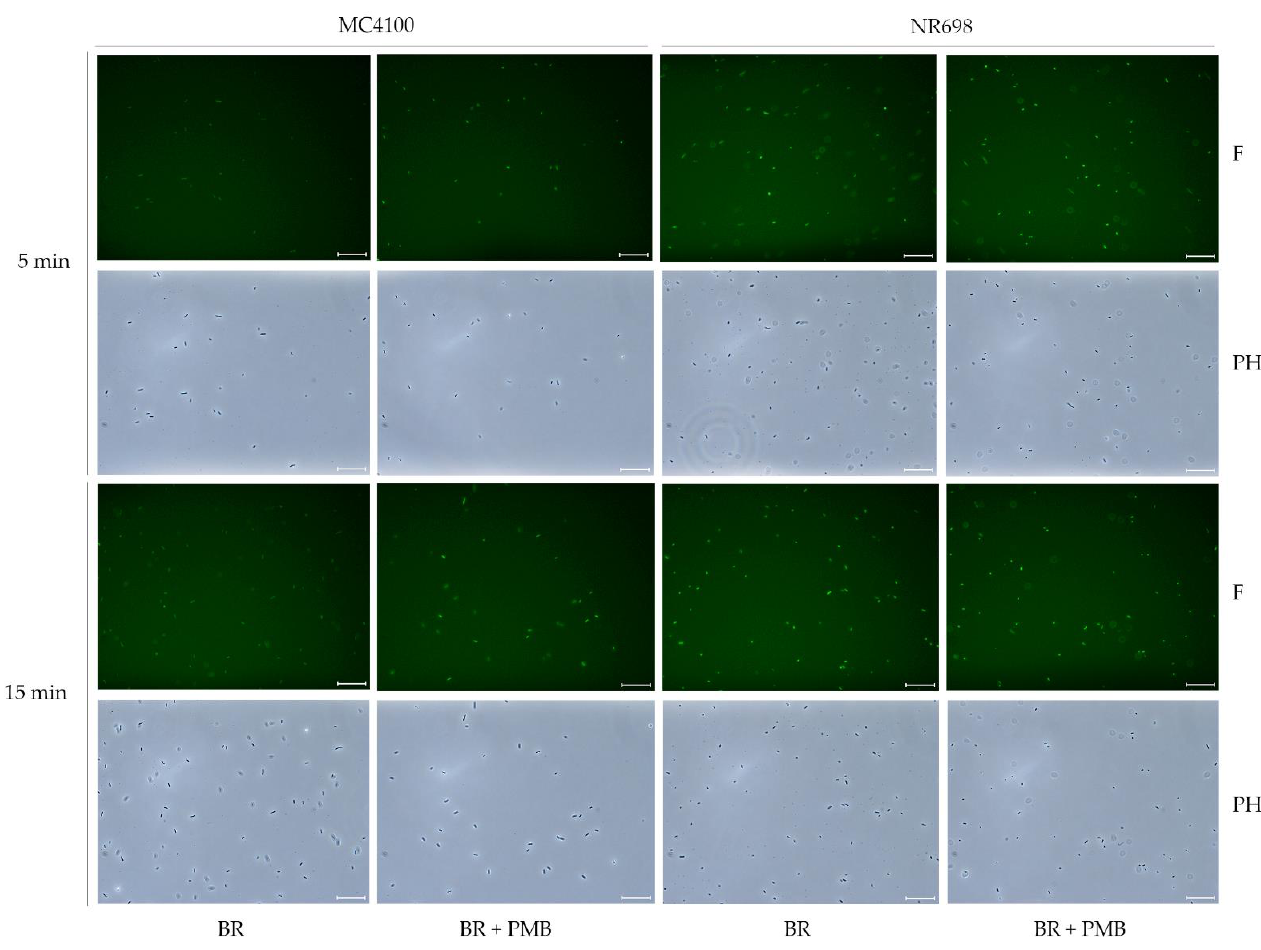
Figure 9. PMB induces population-wide fluorescence of UnaG-expressing E. coli cells. Fluorescence images of E. coli MC4100 and NR698 at time points of 5 min and 15 min after exposure to BR (5 μM) (BR) or BR and PMB (10 μg/mL) (BR + PMB) at x400 magnification. The images were taken with the phase contrast (PH) and with fluorescence (F) through the software LAS X. The scale bars represent 25 μm. For better visibility on all monitors, the brightness of the fluorescent pictures (F) was equivalently increased to 150 with Adobe Photoshop CS6 version 13.0.